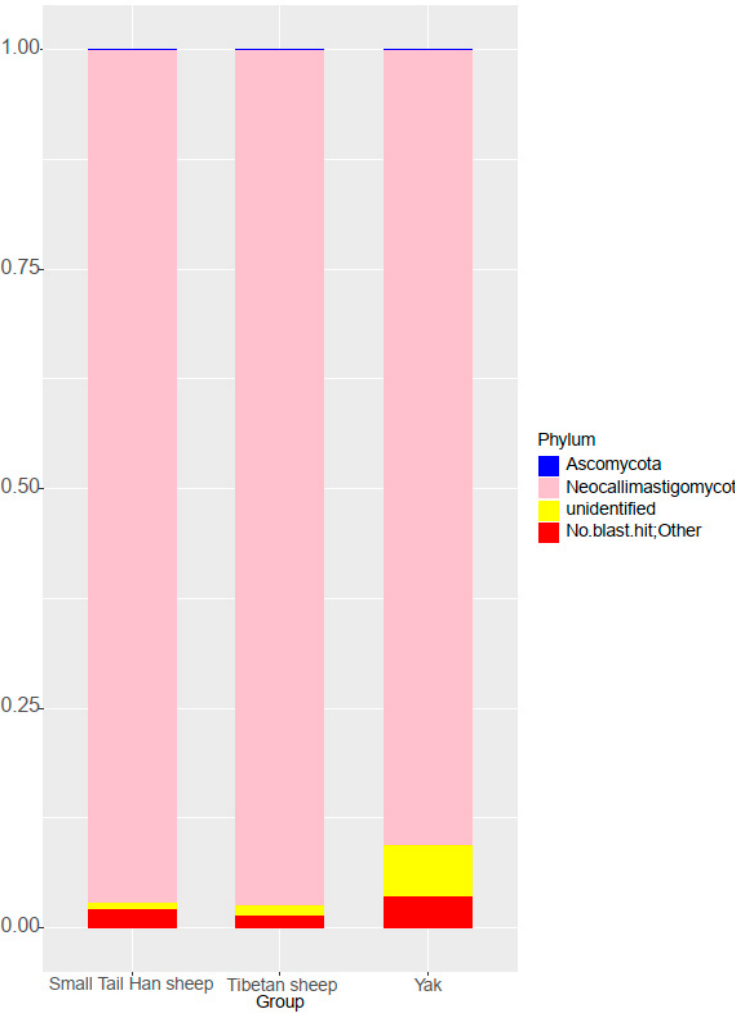
Figure 3. Taxonomic composition of fungal community at the phylum level.